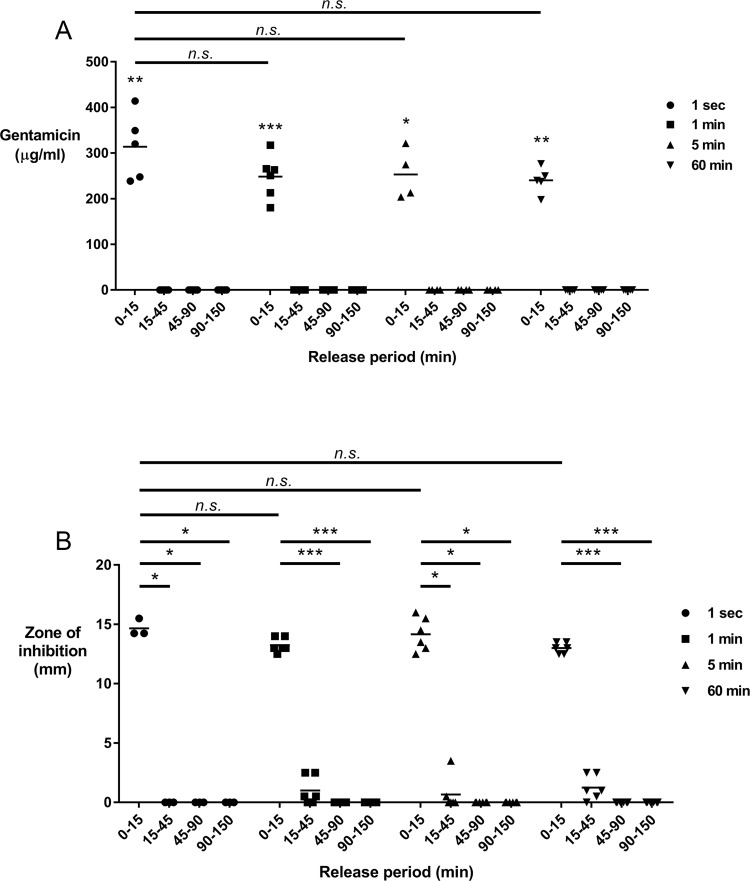
Characterization of gentamicin uptake, release, and antibacterial effects following loading onto the CaP coating.A.) Uptake and release kinetics of gentamicin loading of CaP-coated TAN discs. 13 mm diameter TAN discs coated with CaP were immersed in 40 mg/ml gentamicin solution for varying periods (See figure legend: 1 s–filled circles, 1 min–filled squares, 5 min–filled triangles, 60 min–filled inverted triangles) before transfer into sterile PBS for 15 min (0–15), followed by further serial transfers into fresh PBS for defined periods (15–45 min; 45–90 min; 90–150 min). The horizontal line indicates the mean from 4–6 individual experiments. B.) Antibacterial efficacy of the elution solutions from part A. Zone of inhibition (ZOI) assays involving a gentamicin-sensitive S. aureus strain were performed to confirm the gentamicin released from the CaP coating retained antibacterial efficacy. Data shown are the mean of 3–6 independent experiments. *p<0.05; **p<0.01; ***p<0.001; n.s. = not significant.